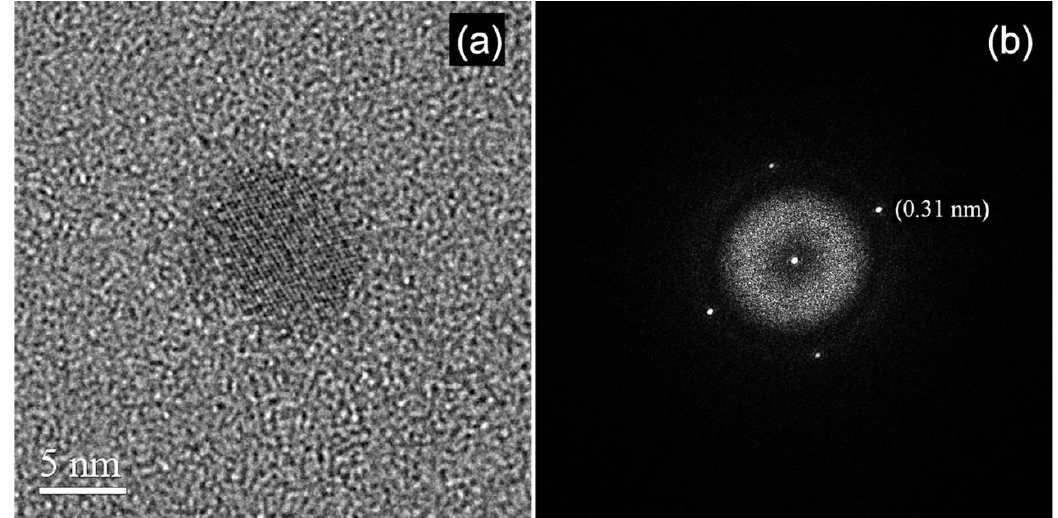
Figure 4. Low dose rate HRTEM image ( a ) and relevant diffractogram from a crystalline particle of Vinpocetine ( b ). The lattice spacing measured on the diffractogram is reported.